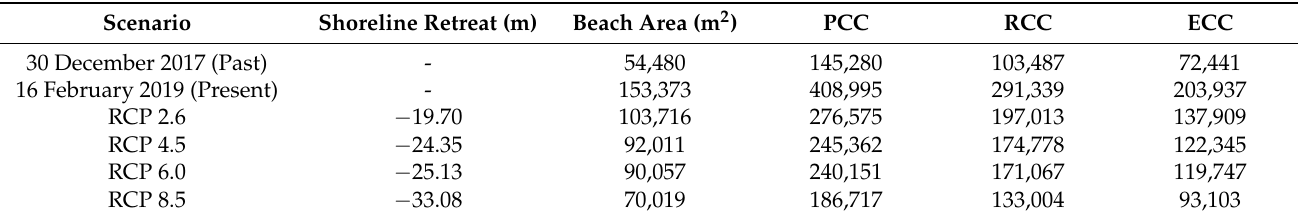
Table 2. Pattaya beach.